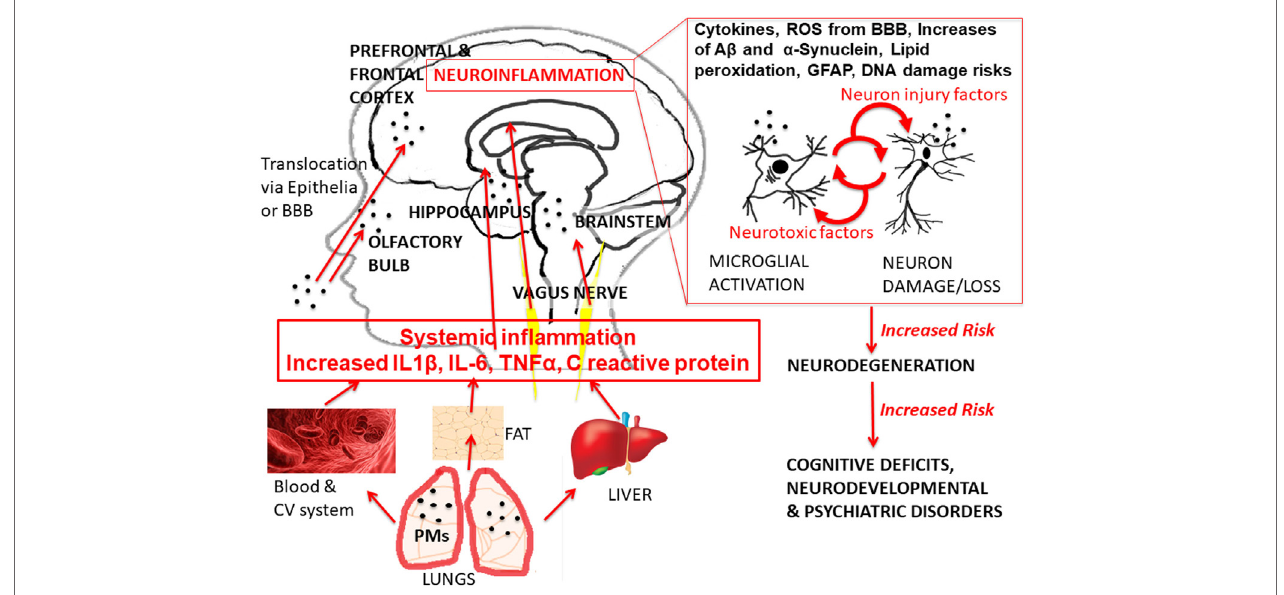
FiGUre 1 | Glance overview of current hypothesized pathways of urban air pollution effects. The graph shows the exposure of urban outdoor air pollution [with specific example of exposure to particulate matter (PM)], the hierarchical cascade, and recursive mechanisms of action leading to the different health effects, with particular focus on healthy brain development outcomes. Abbreviations: IL-6, interleukin 6; IL-1 β , interleukin 1 beta; TN F- α , tumor necrosis factor alpha; BBB, brain–blood barrier; ROS, reactive oxygen species; GFAP, astrogliosis; A β , beta amyloids. The anatomical illustrations (blood cells, liver, and adipose tissue) are modified versions of copyright- and attribution-free public domain images downloaded from